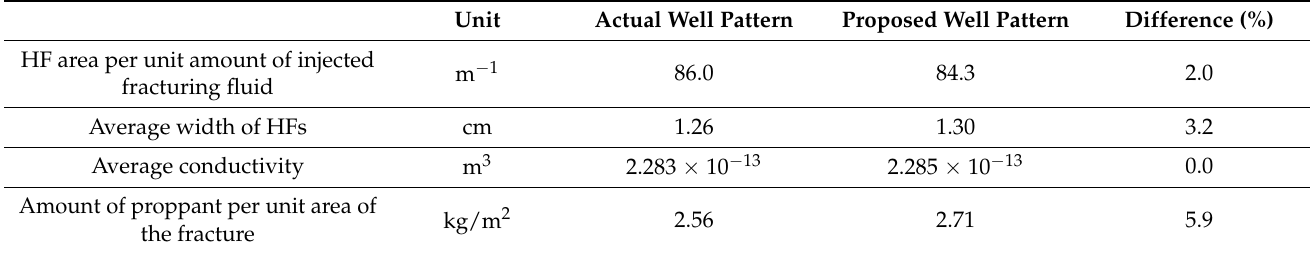
Table 3. Results of hydraulic fracture (HFs) generation.